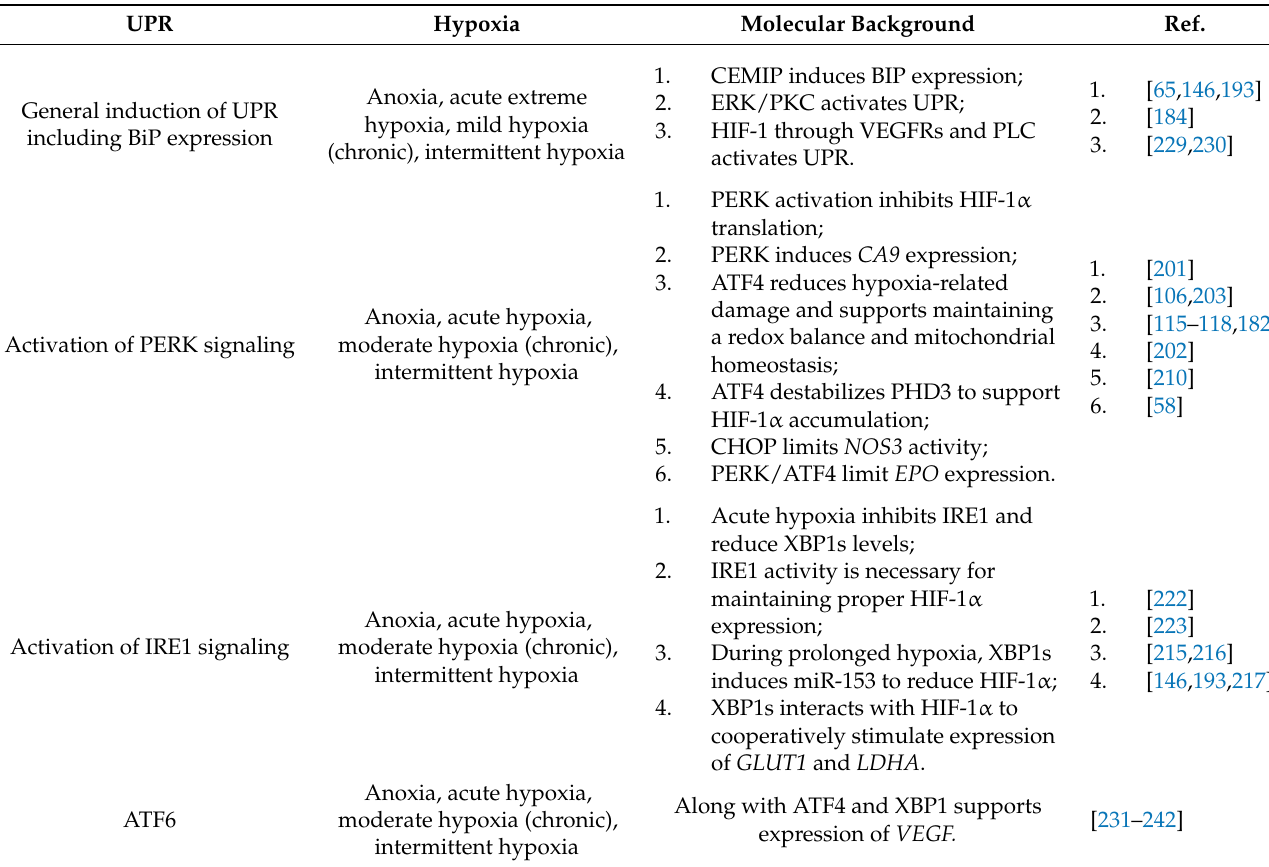
Figure 2. The crosstalk between UPR and hypoxia signaling. During hypoxia, the accumulation of misfolded/unfolded proteins in ER and mitochondria activate PERK signaling, and this contributes to both pro-survival (global translational arrest and induction of pro-angiogenic genes) and apoptotic responses (induction of CHOP and inhibition of pro-angiogenic eNOS expression). Furthermore, in some models, the hypoxia-related activation of ATF6 and IRE1 α contribute to pro-survival and pro-angiogenic signaling. There also appears to be cooperation between XBP1s and HIF1 in pro- survival signaling. Table 1. The crosstalk between UPR and hypoxia